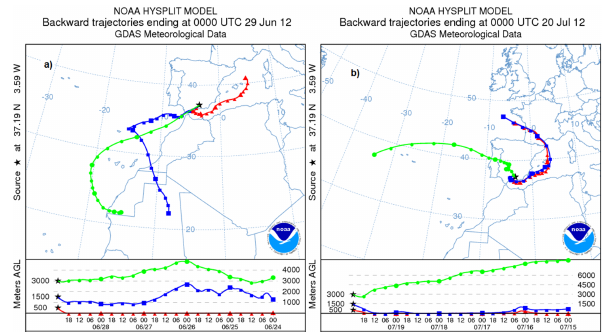
Figure 6. Five-day back trajectories from HYSPLIT at three differ- ent heights (500 (red), 1500 (blue), and 3000m (green) a.g.l.) for (a) 29 June and (b) 20